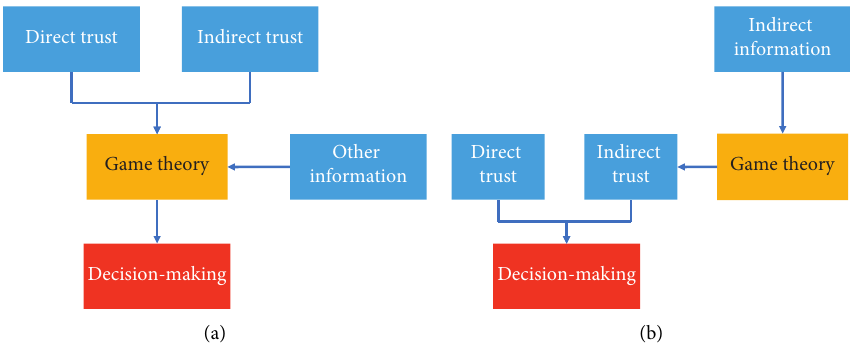
Figure 2: Game-based trust. (a) Game theory is used to synthesize direct trust and indirect trust. (b) Acquiring indirect trust value by using game theory.